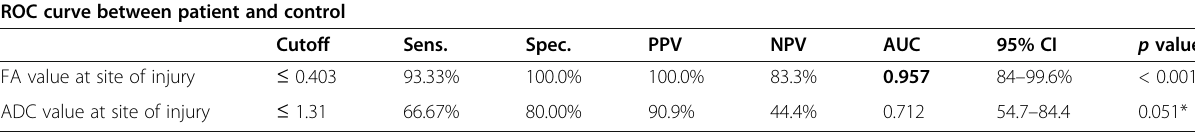
Table 5 Analysis of the diagnostic ability of ADC and FA to differentiate between patients and control groups ROC curve between patient and control